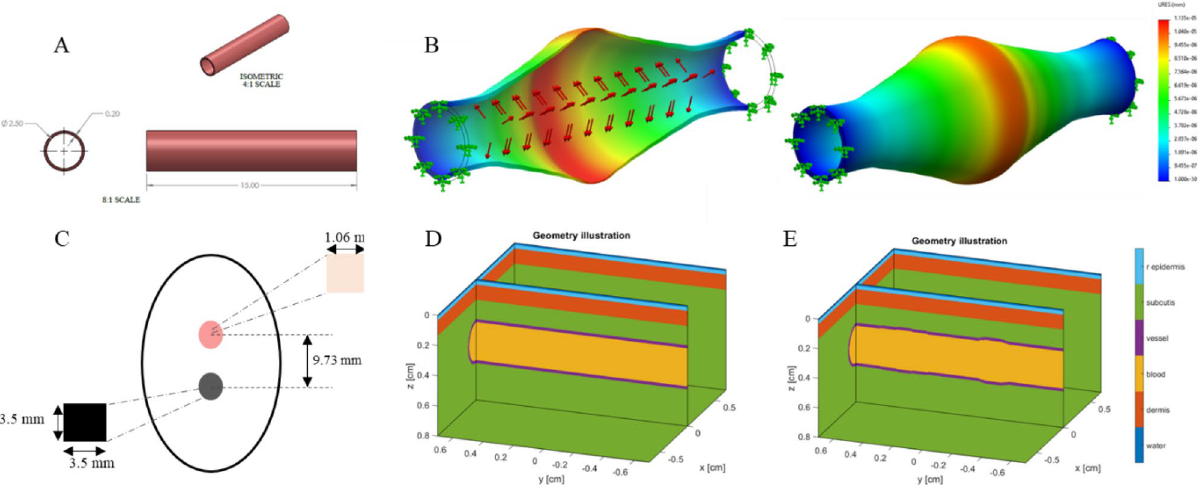
Figure 3. Vessel 2D CAD geometry drawing. This is the model used for the radial artery to understand its behavior during the cardiac cycle. All dimensions in (mm). ( B ) Arterial wall dilation contour plot of total displacement. Red regions show regions of highest displacement and blue for lowest displacement. Note depicted displacement scale is exaggerated. ( C ) Patch sensor schematic for adaptation to Monte Carlo. ( D ) Base geometric configuration for Monte Carlo Model. The various layers represented by a specific color developed in the Monte Carlo geometry. ( E ) Illustration of pulse shape generating features in Monte Carlo. Geometric parameters of arterial dilation and pressure wave propagation is adapted into Monte Carlo through variation in geometry of the artery. Pulse features are developed through Eqs. (2–4).